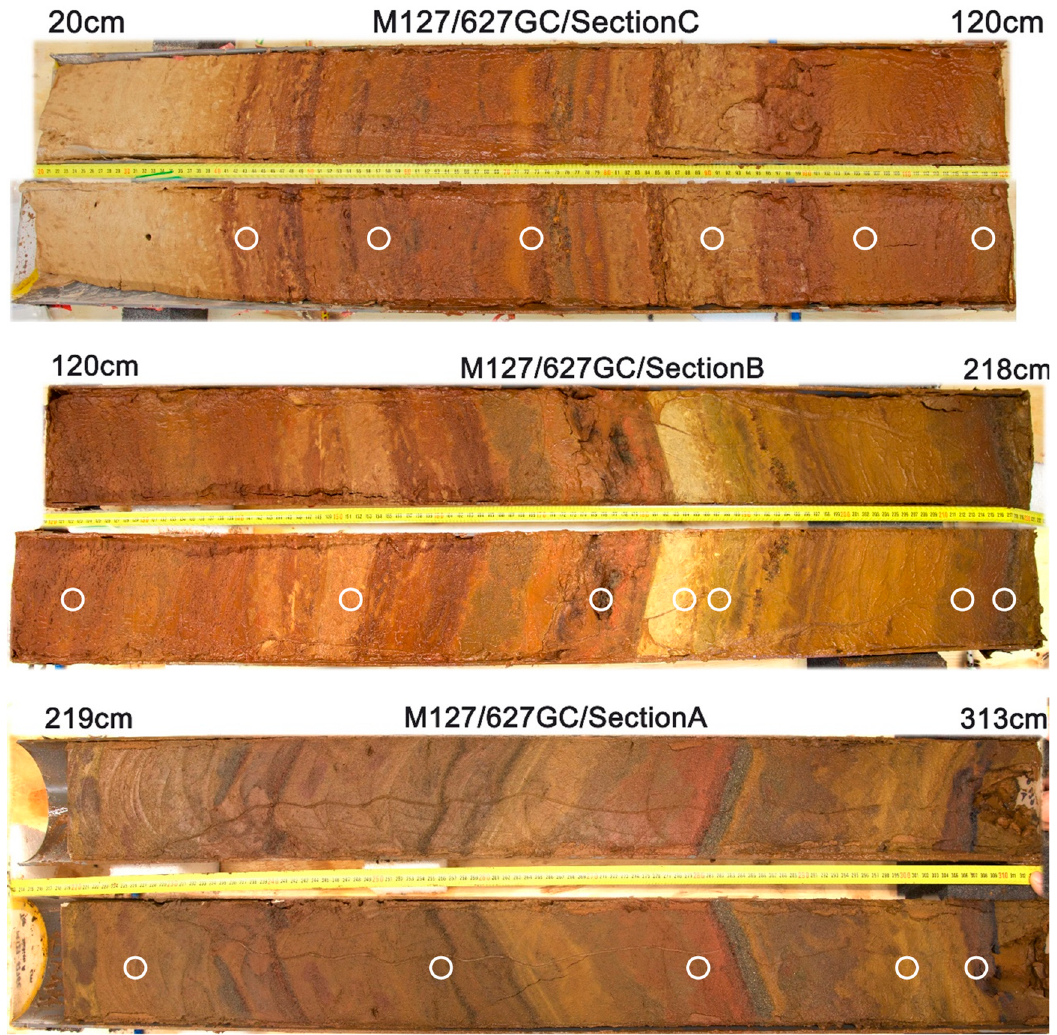
Minerals 2020 , 10 , x FOR PEER REVIEW Figure 5. Image of the GC-627 sections (C, B, A) with sampling points (white circles).